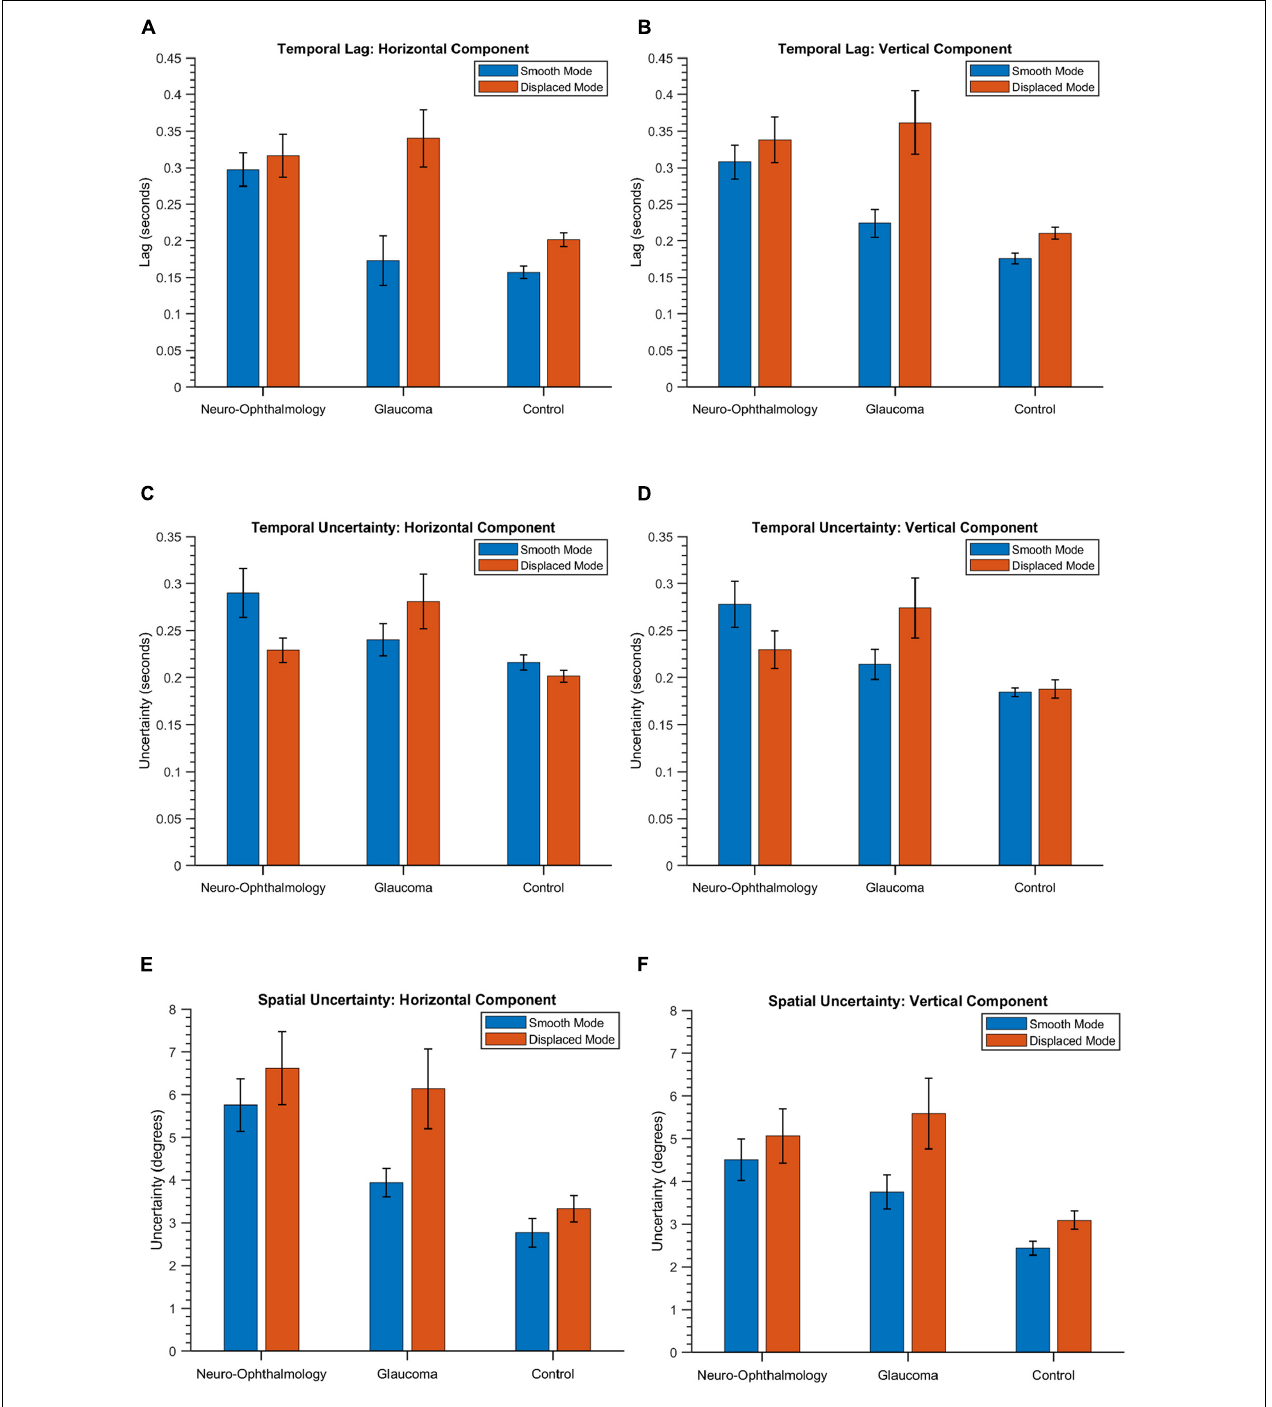
FIGURE 2 | The group means and the corresponding 95% confidence intervals of the temporal lag (A,B) , temporal uncertainty (C,D) and spatial uncertainty (E,F) in both the modes and across the two positional components for the three groups. The values are obtained from the STPs CCG Mean , CCG Standard Deviation , and PED Standard Deviation , respectively (see section “Eye-Tracking Data Preprocessing and Spatio-Temporal Properties” and Supplementary Table 3 ).